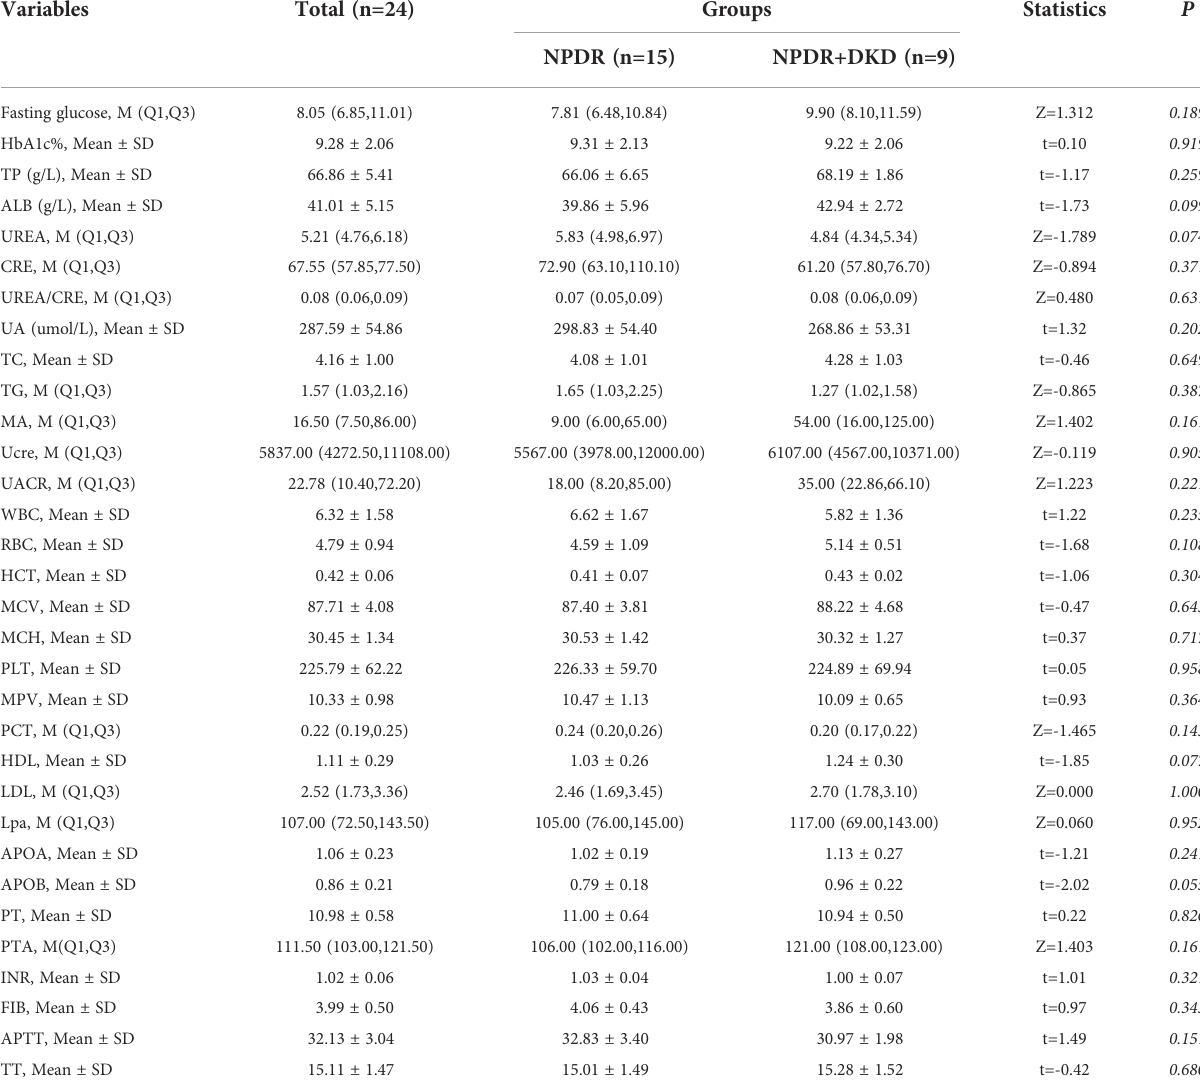
TABLE 2 Clinical features of NPDR and NPDR+DKD patients for LC-MS/MS analysis.